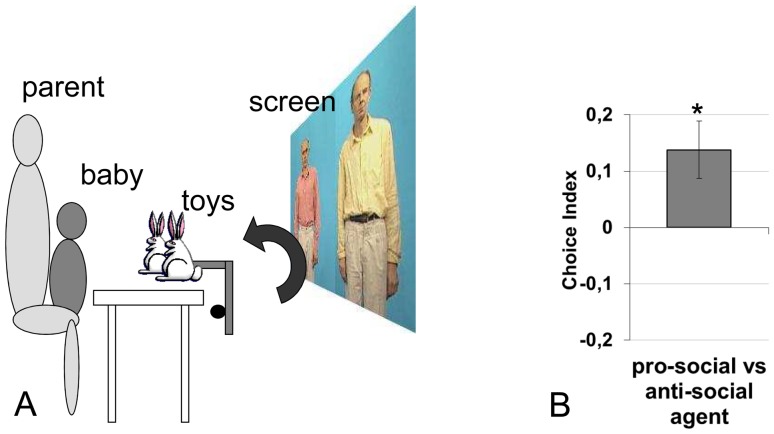
Set up and average preference index for 10-month-olds.A Setup of the experiment for the 10-month-olds. Infants are seated in their parent’s lap (who are blindfolded) during the experiment. After the presentation of the sequences described in Figure 1, infants see a novel sequence, where the two actors appear on stage, stare at the camera, play with two identical toys, and present them to the infants. Simultaneously, two real toys appear on the table through a mechanical device. The infants’ first attempt to reach one of the toys is coded by two independent scorers. Infants are tested 4 times with different toys, and the actors switching places on the screen. B. Average preference index for 10-month-olds computed over the 4 response trials. A positive score indicates a preference towards the toy of the pro-social agent, a negative score, a preference towards the anti-social agent. The error bars correspond to one between-subject standard error above and below the mean. *p<.05.